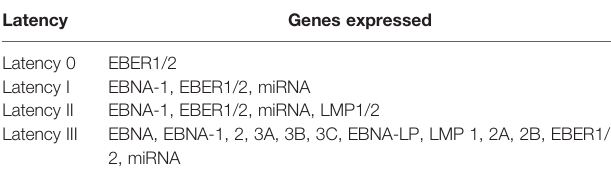
TABLE 1 | Latency forms of